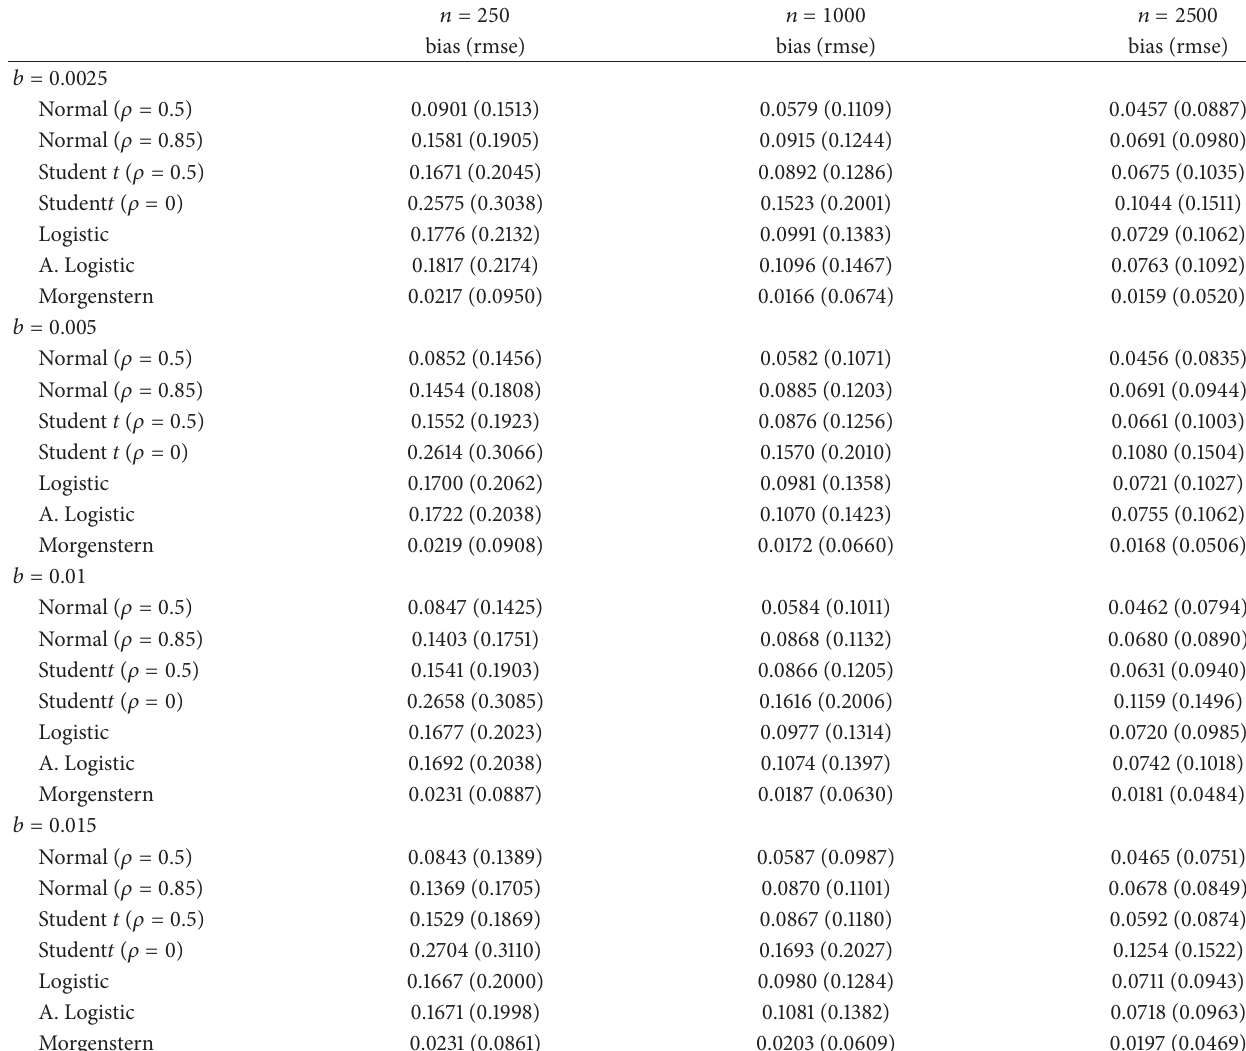
Table 3: Absolute bias and root mean squared error (rmse) of estimator ̂𝜂